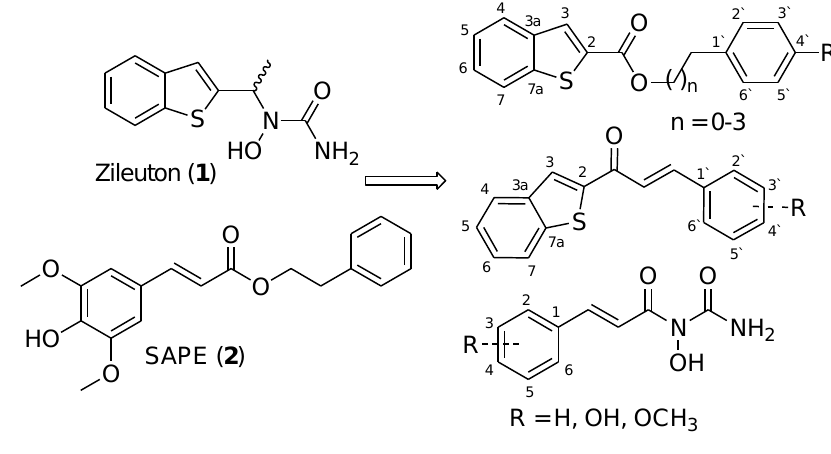
Figure 2. Designed compounds. Figure 2. Designed